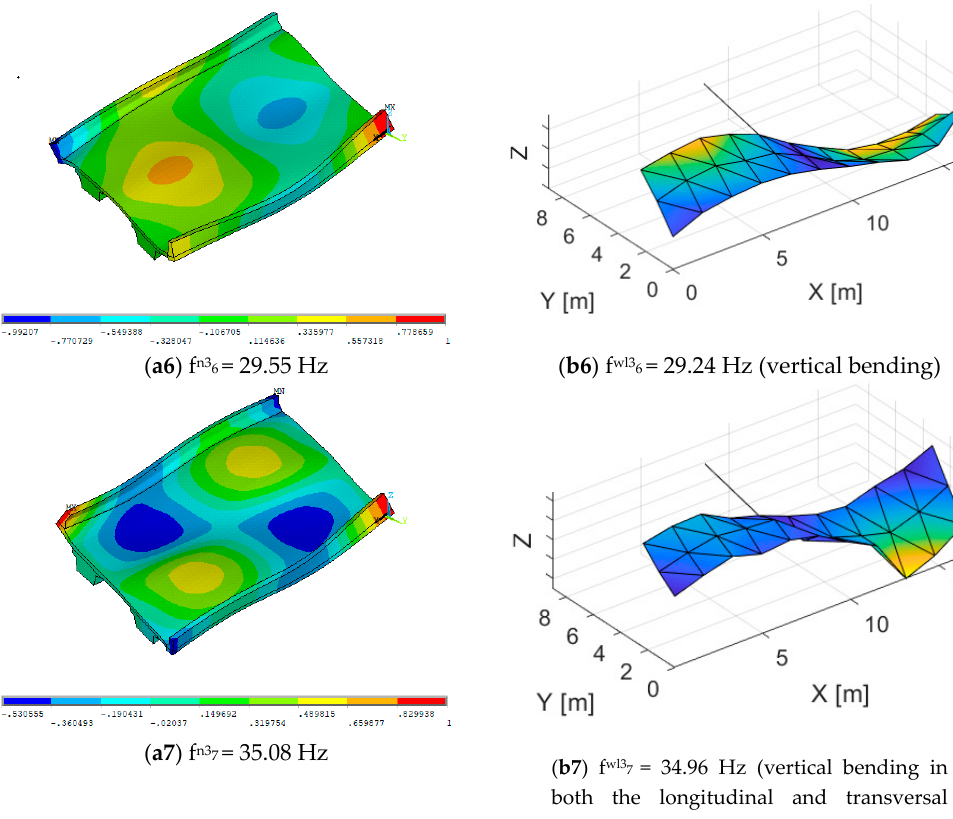
Figure 5. Comparison of the experimental and numerical mode shapes: ( a ) those of the updated FE model (n3); ( b ) those of the identified results (WL3).